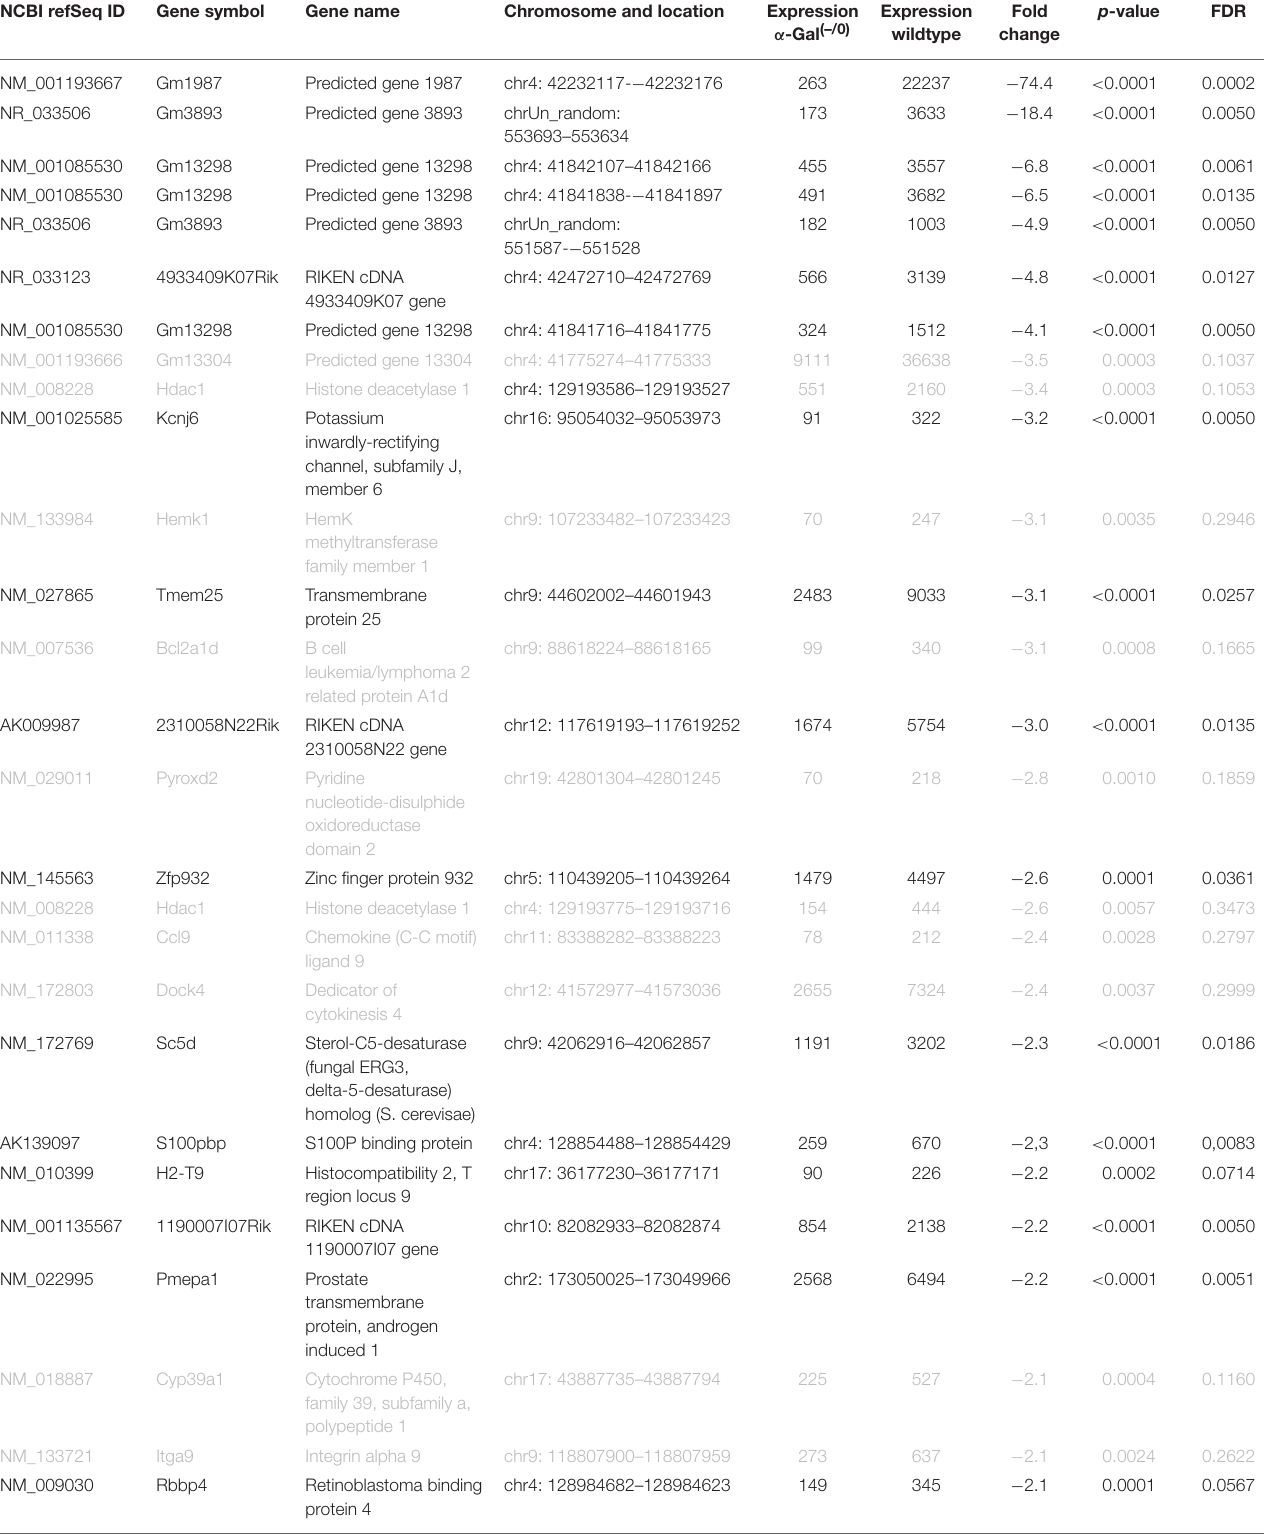
TABLE 2 | Raw expression values, fold changes, and statistical analysis for significantly downregulated